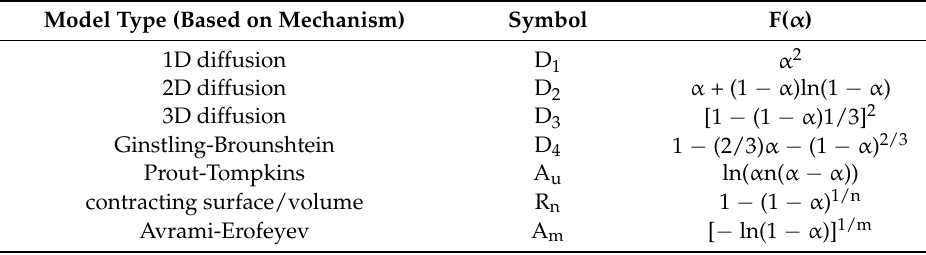
Table 2. Seven Common Forms of F( α ) a